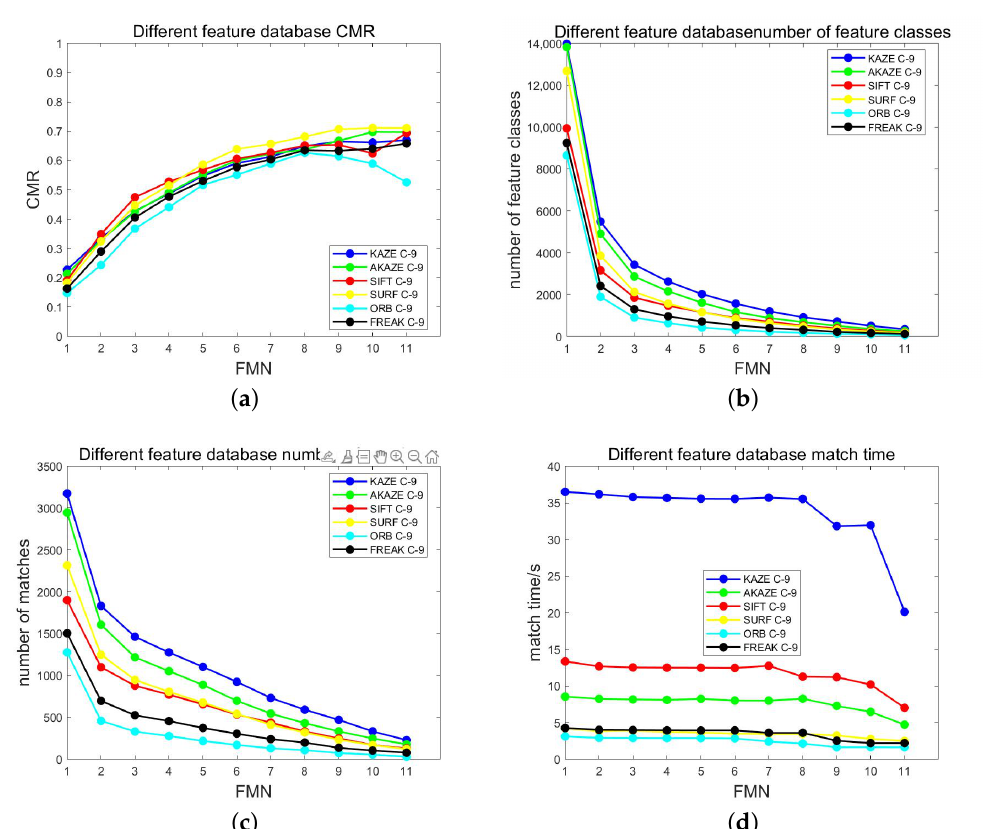
Figure 10. Different feature database comparison ( a ) CMR . ( b ) the number of feature classes. ( c ) the number of matches. ( d ) match